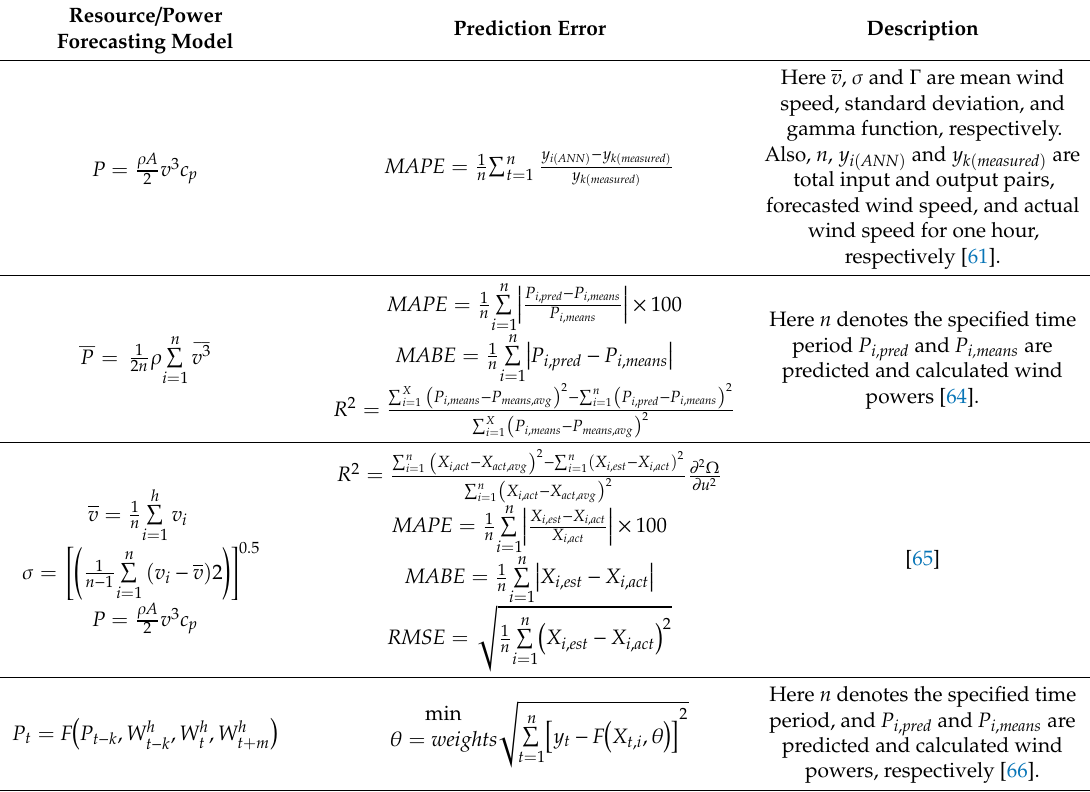
Table 3. Wind resource and power prediction with WD and NN and prediction